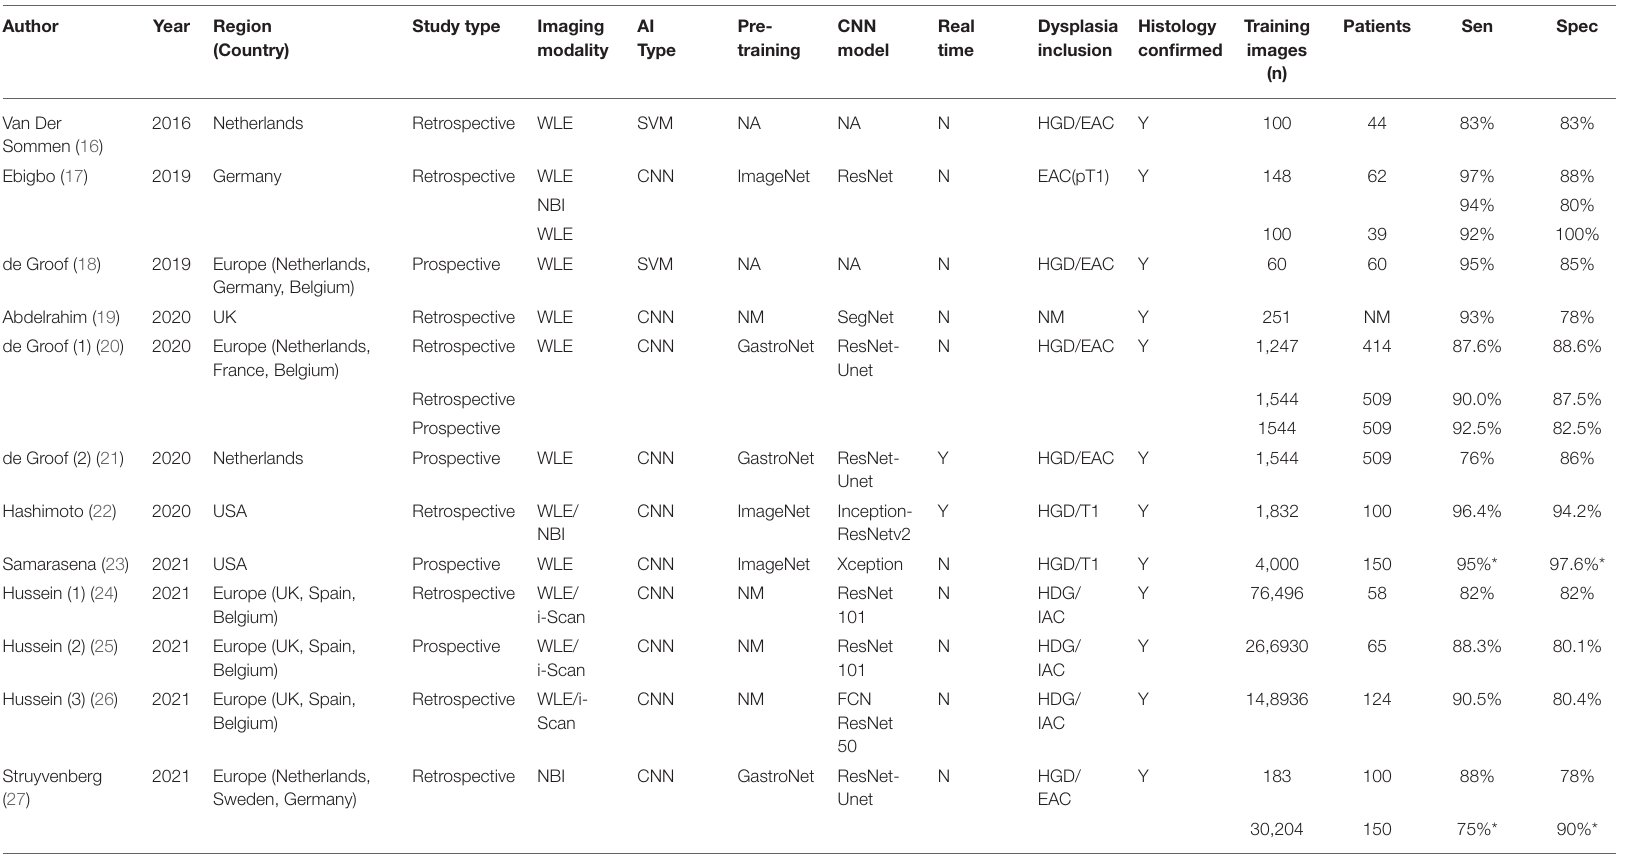
TABLE 1 | Study characteristics of included